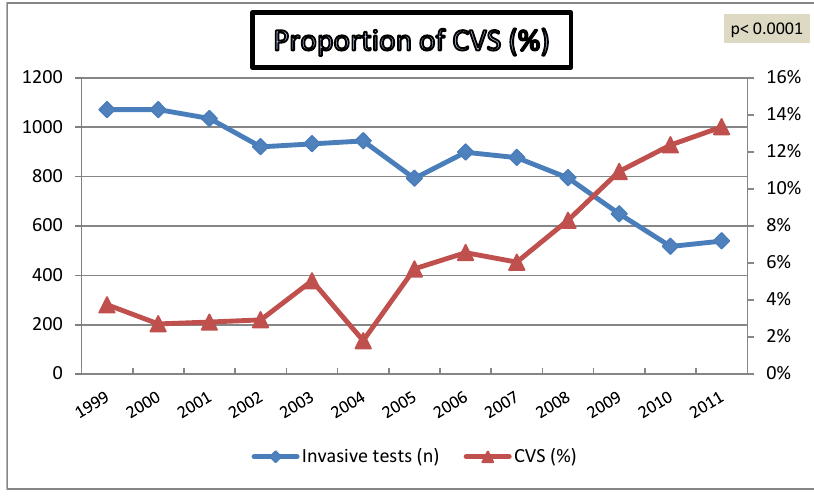
Figure 2. Annual proportion of chorionic villus sampling